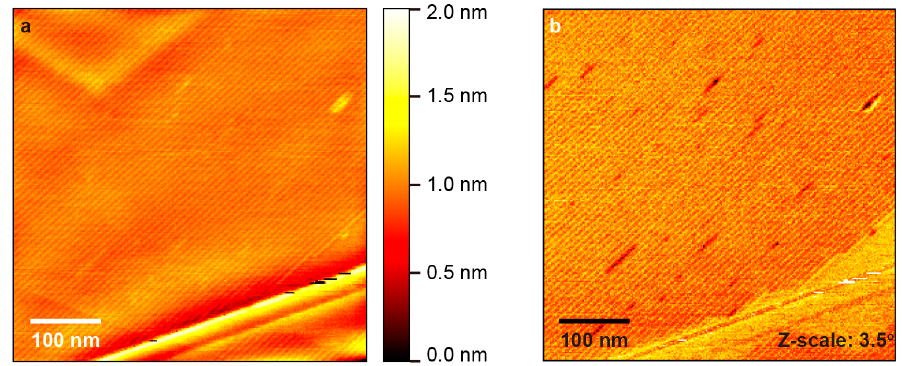
Figure 1 . Atomic force microscopy (AFM) images showing diacetylene on highly oriented pyrolytic graphite (HOPG) after 20 min of ultraviolet (UV) irradiation: (a) topography; (b) phase shift.